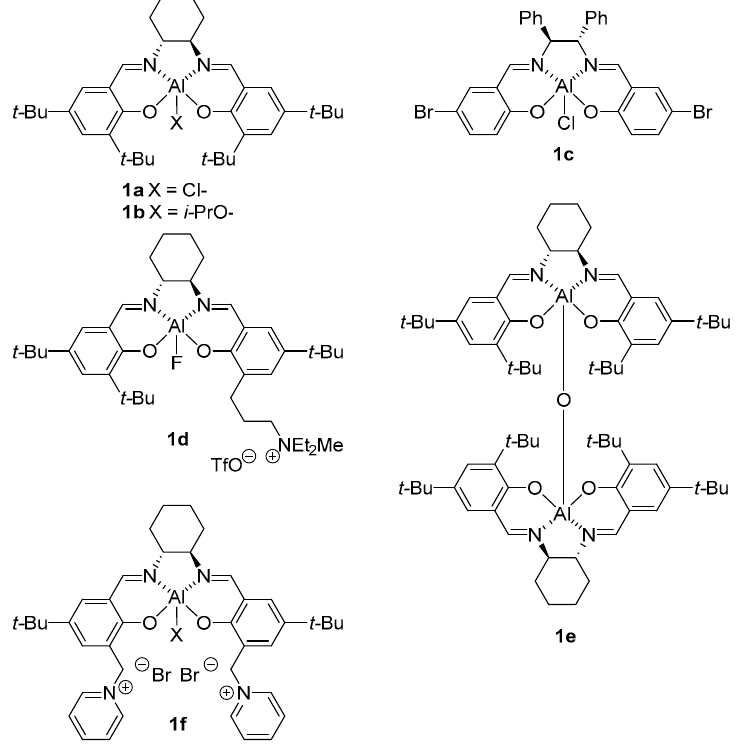
ff ective Al(salen) complexes used for stereoselective Figure 3. Effective Al(salen) complexes used for stereoselective reactions. Figure 3. E